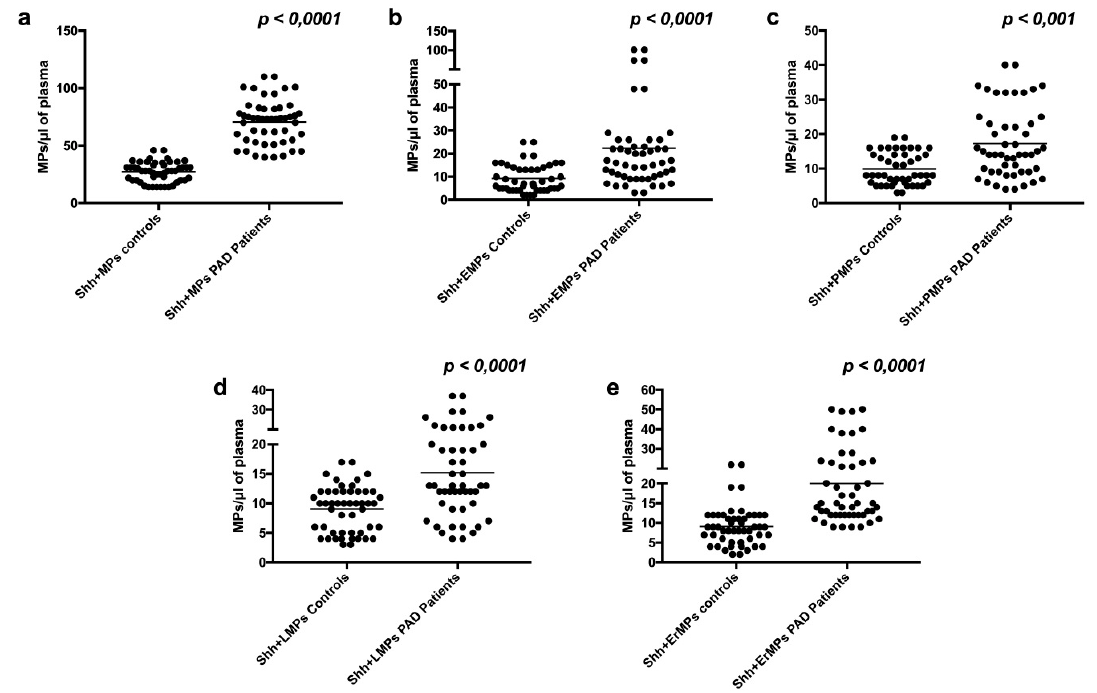
Figure 2. Global number of Sonic hedgehog (Shh) + microparticles (MPs) in PAD patients and controls ( a ); number of Shh + EMPs ( b ), Shh + PMPs ( c ), Shh + LMPs ( d ), and Shh + ErMPs ( e ) in PAD patients and controls. p : p -value; n.s .: not significant. Black horizontal lines in panels indicate median values.